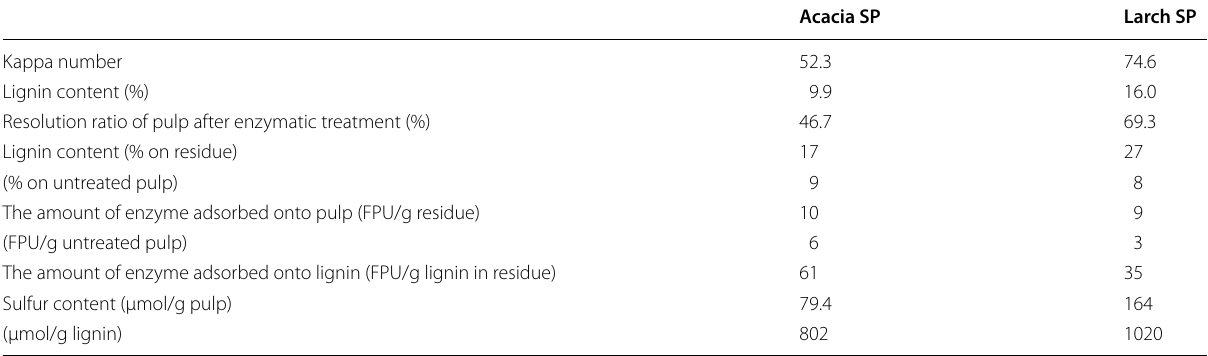
Table 2 The amount of enzyme adsorbed onto acacia and larch SP estimated using Py-GC/MS analysis and sulfur content of untreated SP